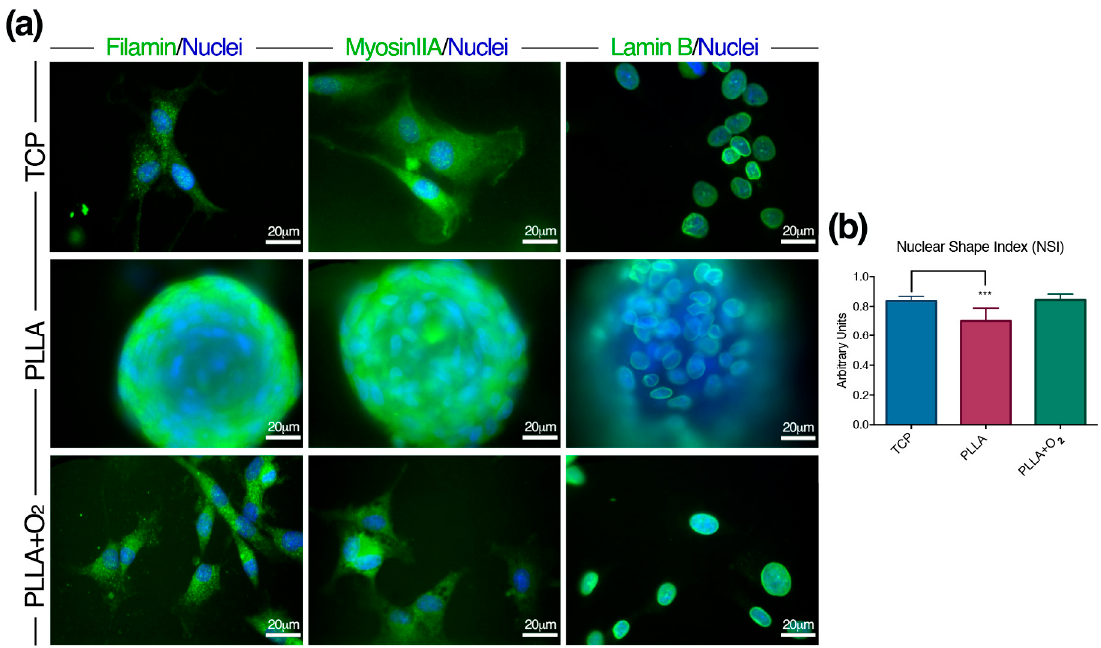
Figure 4. hASCs architecture on PLLA and on PLLA+O 2 . ( a ) Representative immunofluorescence images of Filamin-A, Myosin-IIA and Lamin-B proteins in hASC spheroids on PLLA, and fibroblast-like hASCs on PLLA+O 2 and on TCP; and ( b ) NSI in hASCs on PLLA, PLLA+O 2 , and TCP (see methods for details). *** p ≤ 0.001.